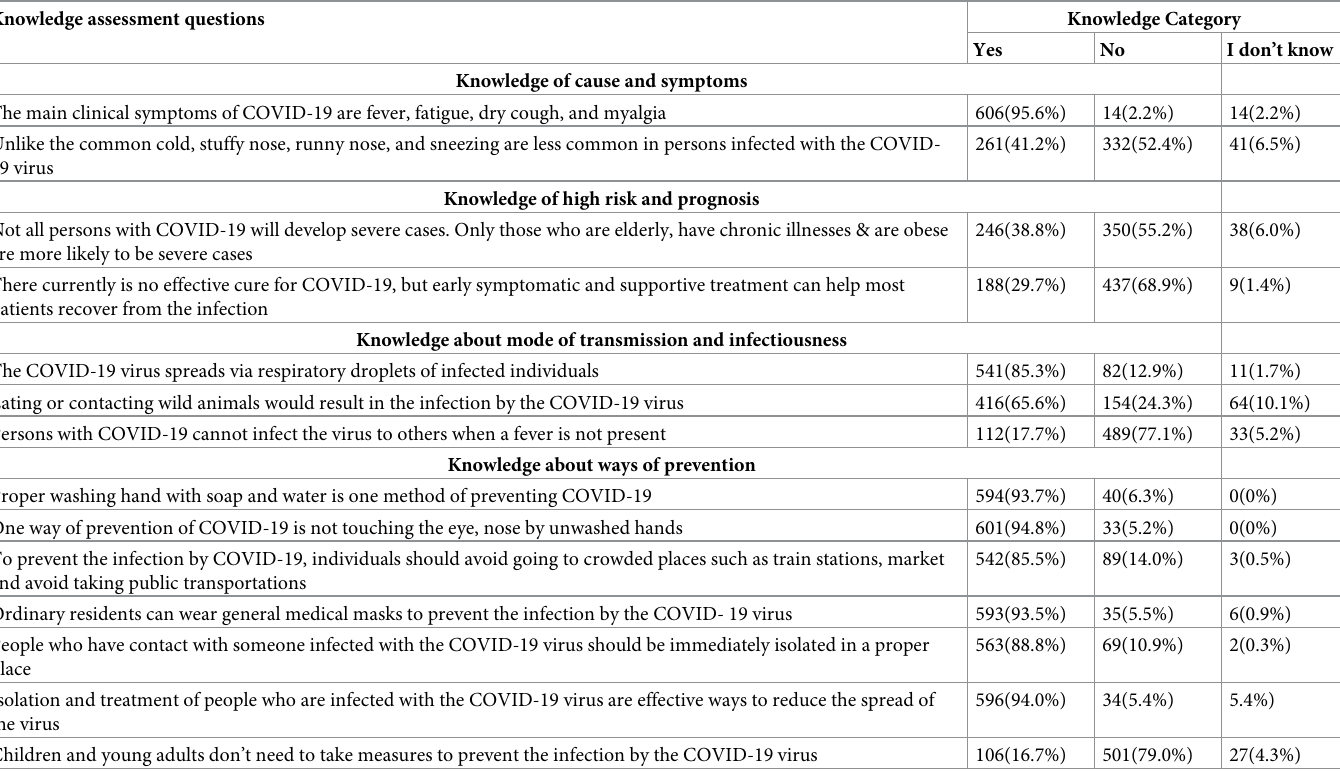
Table 2. Knowledge status of the respondents on COVID-19 among residents in Guraghe Zone, 2020 (n = 634). Knowledge assessment